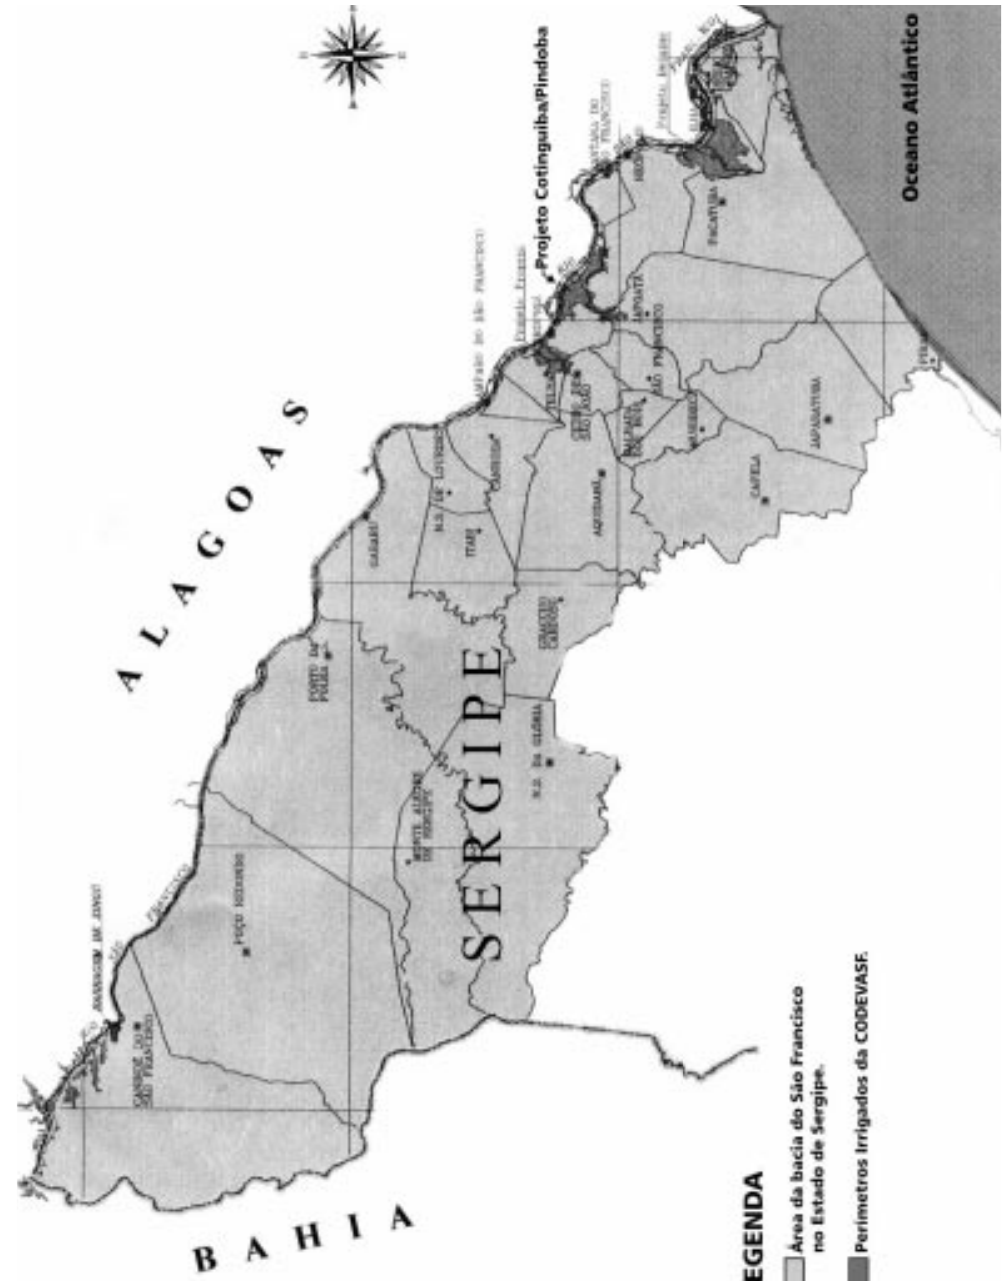
Figura 1. Localização do perímetro irrigado